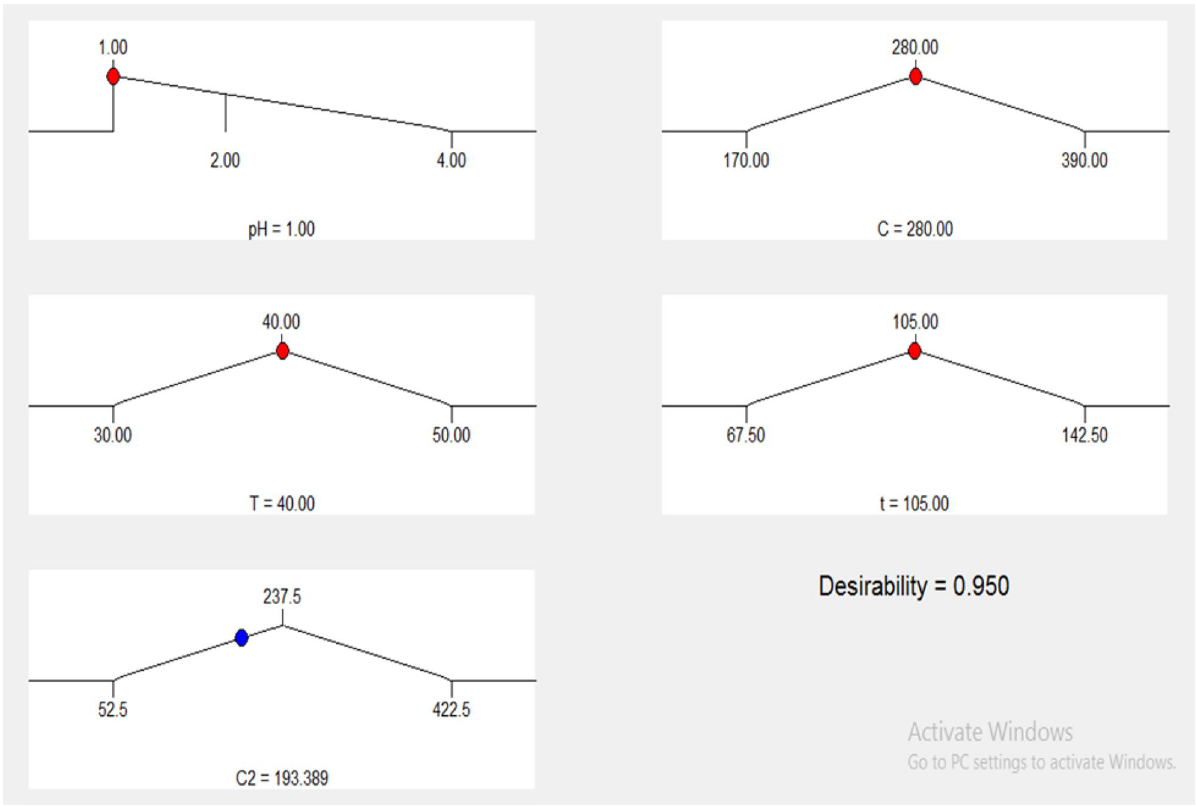
Figure 12. Desirability ramp for